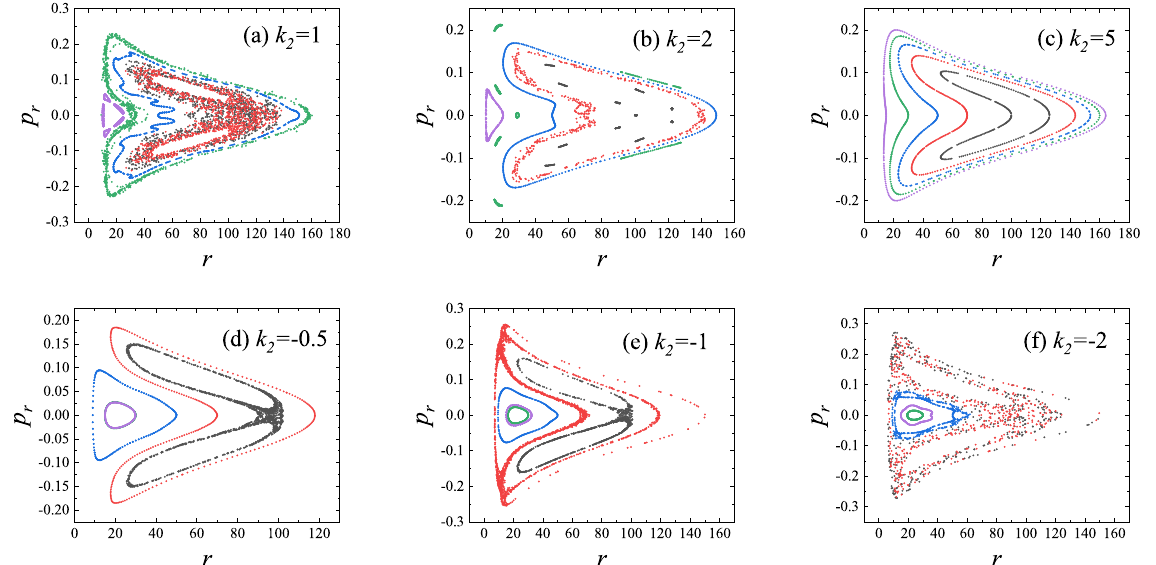
Figure 11. Poincaré sections for different values of the deformation parameter k 2 . The parameters are L = 4.6, Q = 8 × 10 − 4 , k 0 = 5 × 10 − 4 , k 1 = 5 × 10 − 3 and k 3 = 1. ( a – c ): E = 0.995 and k 2 > 0. The strength of chaos is weakened with increasing k 2 . ( d – f ): E = 0.994 and k 2 < 0. Chaos is enhanced as | k 2 | increases.